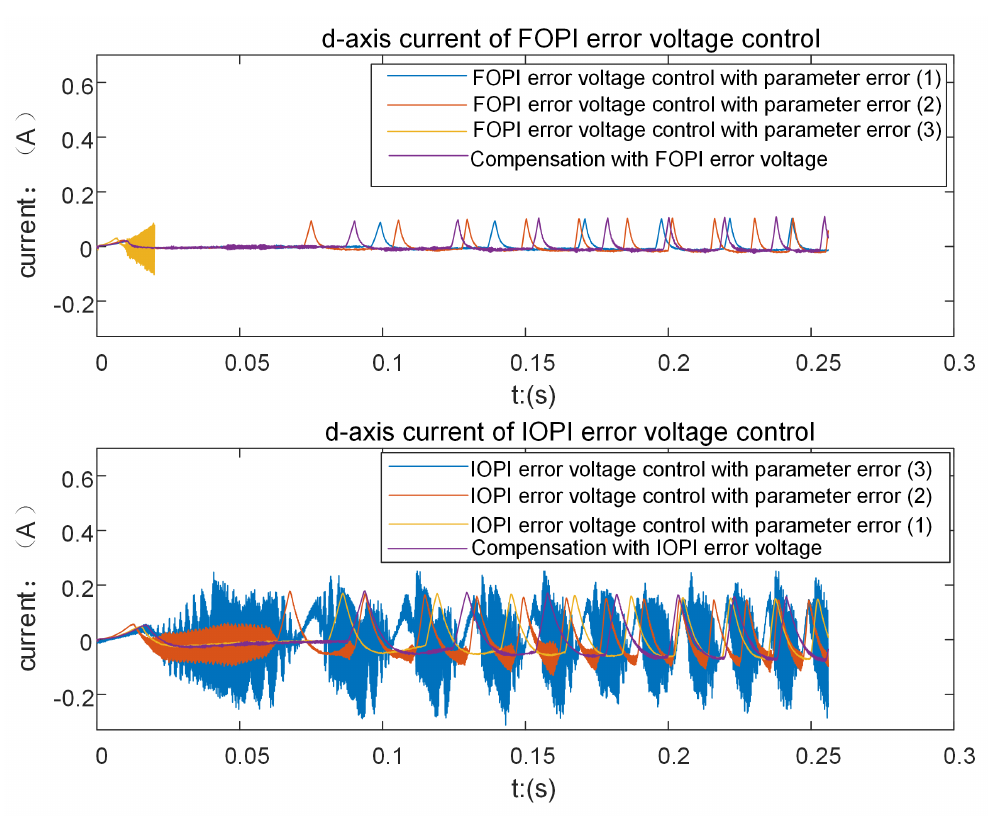
Figure 21. The comparison of I d step current response in the error motor